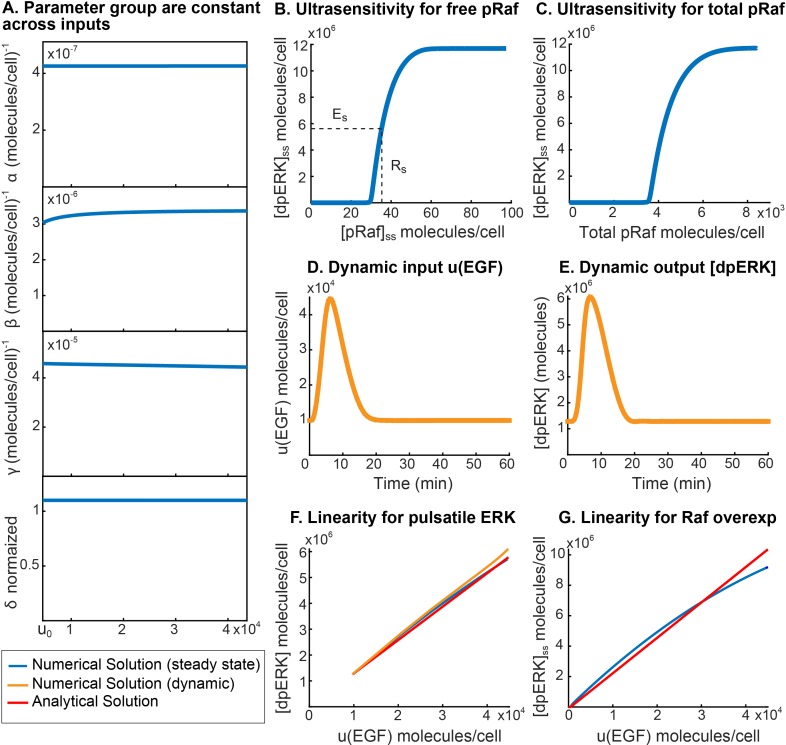
Model simulations for the ERK pathway.(A) Parameter groups in the ERK model are constant to within 10%, over the physiologically relevant range of u considered here, justifying the inclusion of variables into the parameter groups. (B–C) The dpERK output is an ultrasensitive function of both free and total phosphorylated Raf. The values Es and Rs are illustrated in (B), and are defined in Appendix 1. (D–F) Numerical simulation of pulsatile response in the ERK pathway. (D) A pulse of input, RasGTP, is generated by EGF addition in an ERK model that includes details of receptor desensitization (Schoeberl et al., 2002). Basal activity of Ras is included to ensure constitutive negative feedback (Fritsche-Guenther et al., 2011). (E) dpERK output also exhibits a pulsatile response, peaking within 10 min. (F) We plot the peak dpERK output against peak input for a range of physiologically relevant u(EGF) doses, and find that it matches our steady-state predictions for linear input-output behavior. (G) Five-fold Raf overexpression does not break the linear input-output behavior.